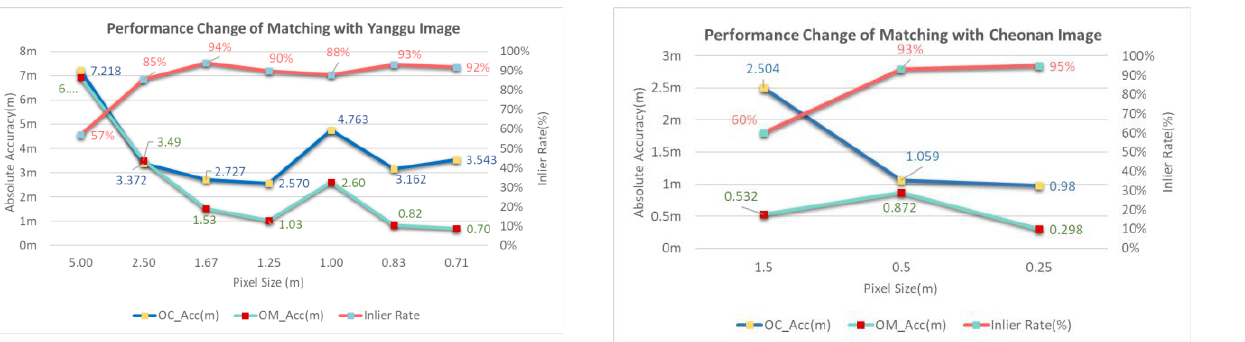
Figure 10. Performance change of matching with Cheonan Kompsat-3A image.